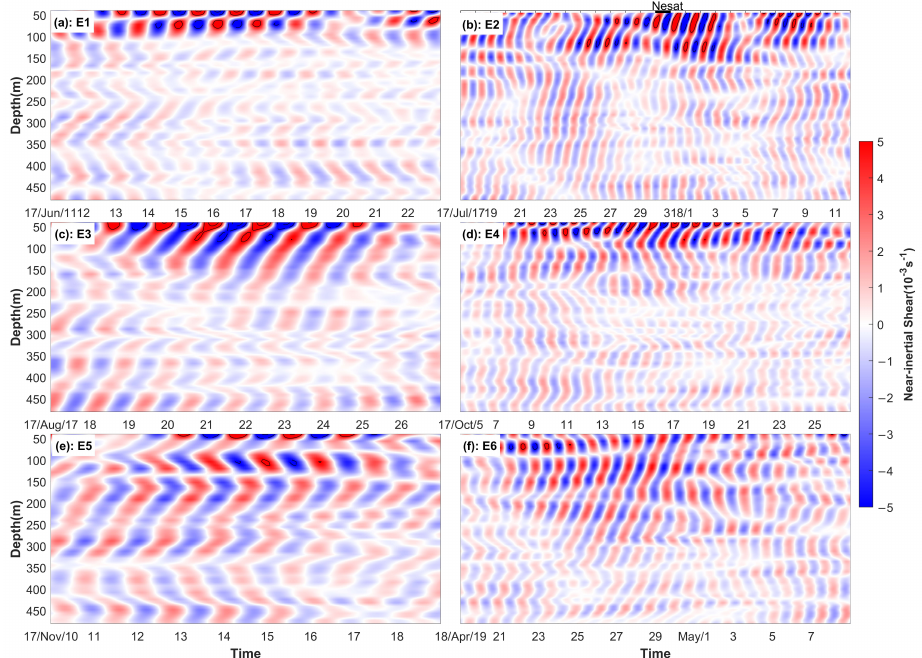
Figure 10. Vertical shear of near-inertial currents. Figures ( a – f ) correspond to episodes 1 to 6. The contours start at ± 0.005 s − 1 with an interval of 0.005 s − 1